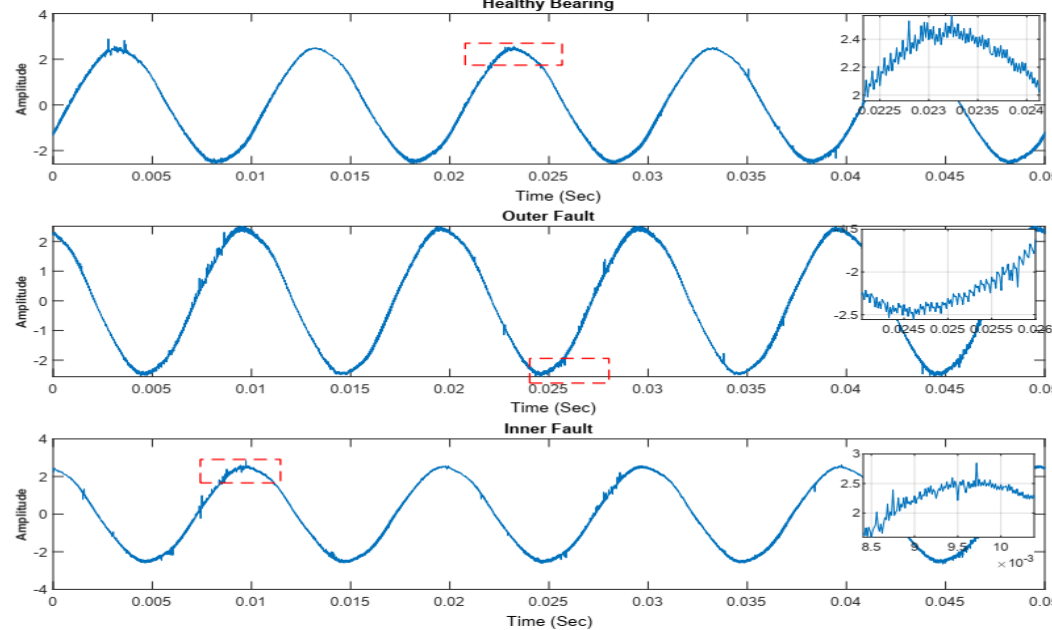
Figure 2. Time domain signal of different bearing conditions.